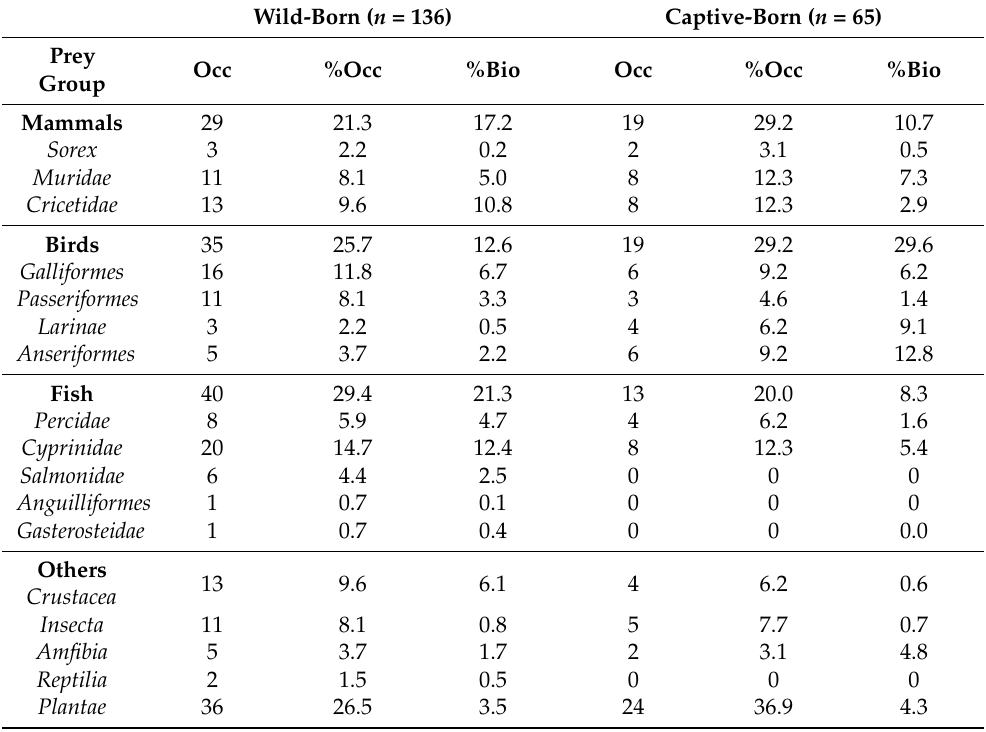
Table 2. Occurrence (Occ), percentages of occurrence (%Occ), and percentage of biomass (%Bio) for wild-born mink ( n = 136) and captive-born mink ( n =